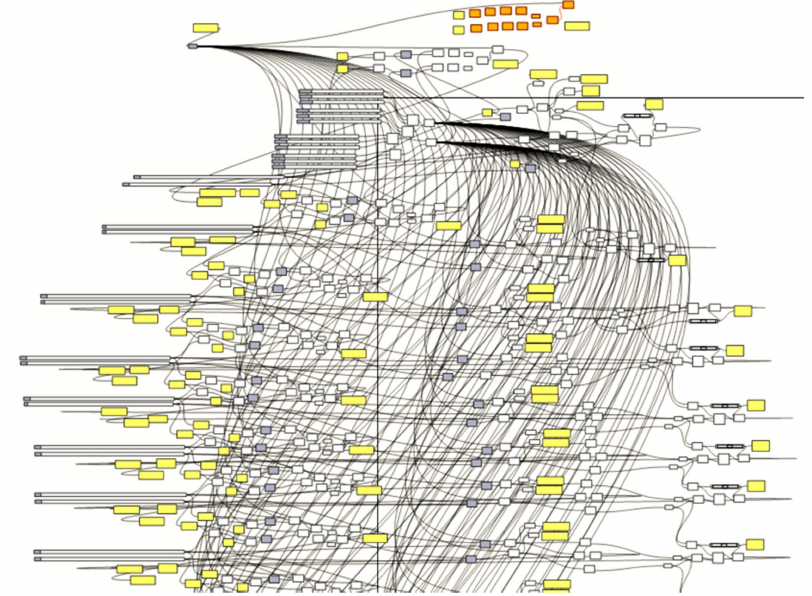
Figure 17. Part of the scheme of many objects creating the parametric algorithm implementing the authors’ parametric